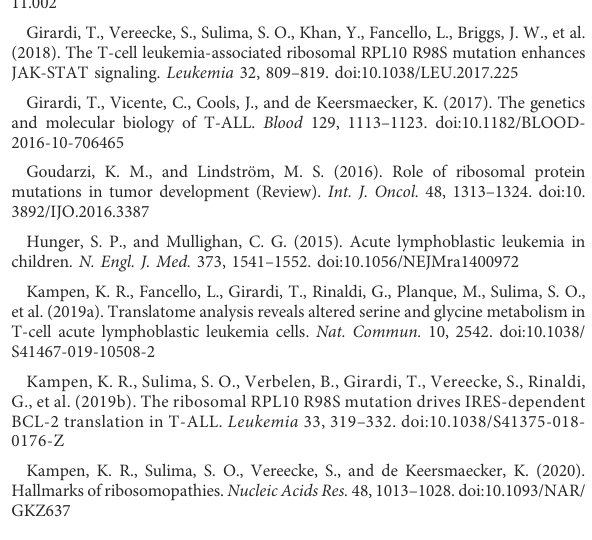
SUPPLEMENTARY FIGURE S1 Gating strategy used to identify T-ALL cells for phospho fl ow analyses. Upper: representative density plot on CD45low/CD7+ blasts and CD45high/CD7+residualnormalTlymphocytes.Lower:representative density plot expressing % of p4EBP1 in a patient carrying RPL10 Q123R mutation (6924) and a patient RPL10 wt (6954). SUPPLEMENTARY FIGURE S2 Sanger results for RPL10 and RPL5 mutations. Representative chromatograms of the presence of the RPL10 or RPL5 mutations in diagnosis or remission genomic DNA. SUPPLEMENTARY FIGURE S3 Basal expression of phosphoprotein pro fi ling in T-ALL samples. Distribution of % positive cells (with median) were measured for each phosphoprotein in 8 T-ALL samples and are represented in a scatter plotgraph. Reddots:6924 T-ALLpatient withtheQ123RRPL10mutation (two independent experiments). Black dots: 5150, 6954, 5123, 7053, 7389, 7449 and 7558 T-ALL patients with wild type